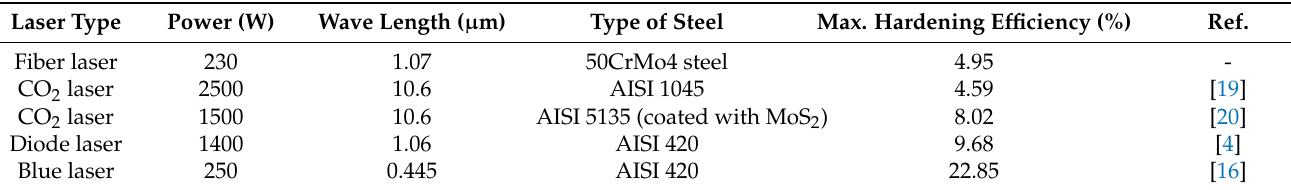
Table 3. Hardening efficiency calculation of different